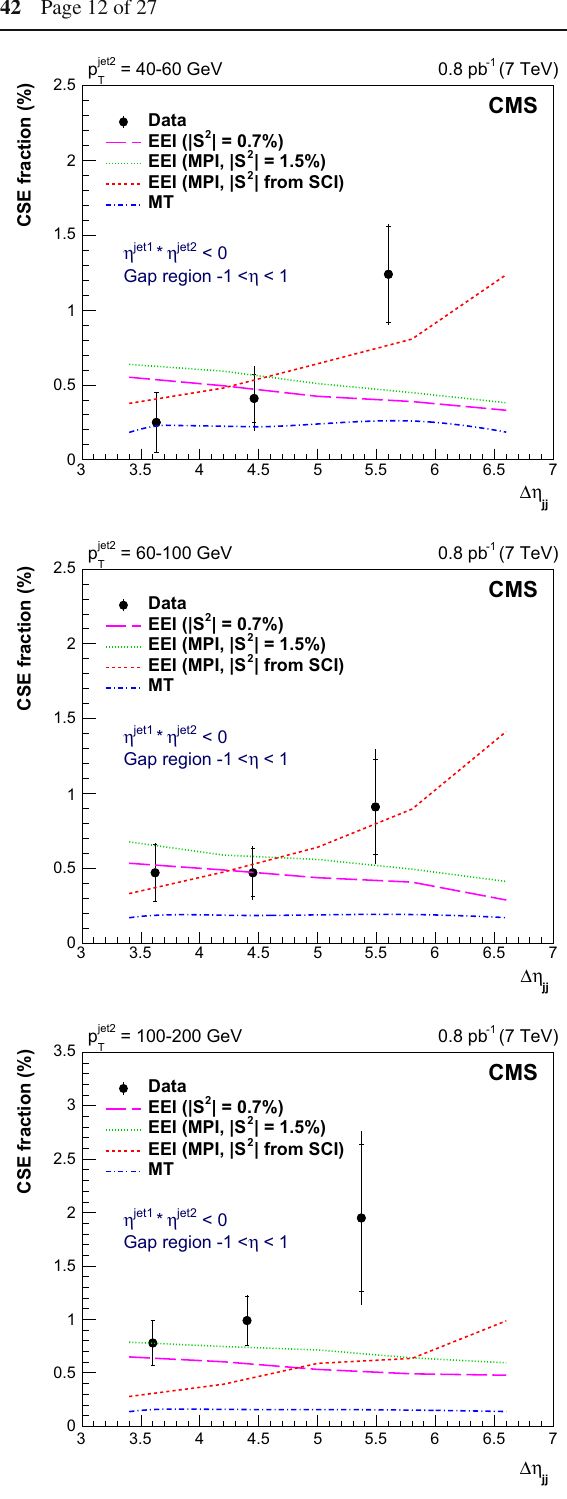
Fig. 10 Fraction of dijet events with a central gap ( f CSE ) as a function √ s = 7 TeV in three different p jet2 of Δη jj at ranges, compared to T the predictions of the Mueller and Tang (MT) model [21], and of the Ekstedt, Enberg, and Ingelman (EEI) model [22,23] with three different treatments of the gap survival probability factor | S | 2 , as described in the text. The results are plotted at the mean value of Δη jj in the bin. Inner and outer error bars correspond to the statistical, and the statistical and systematic uncertainties added in quadrature,